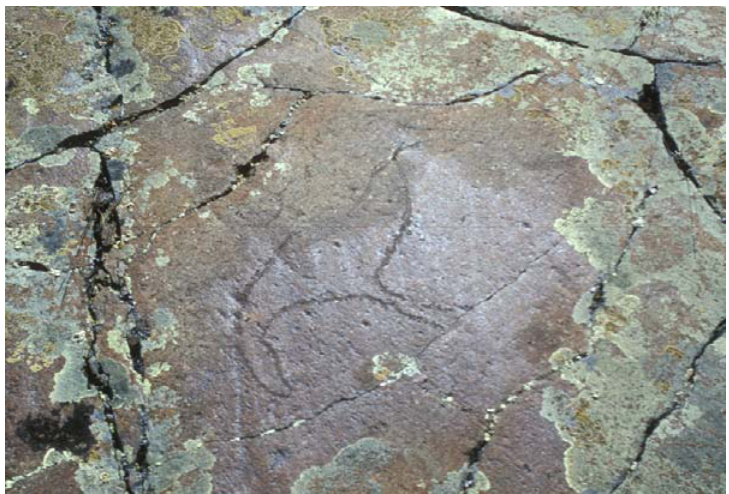
Figure 30. Horse. Pre-Bronze Age. Kalgut River, Ukok Plateau. Photo: E.